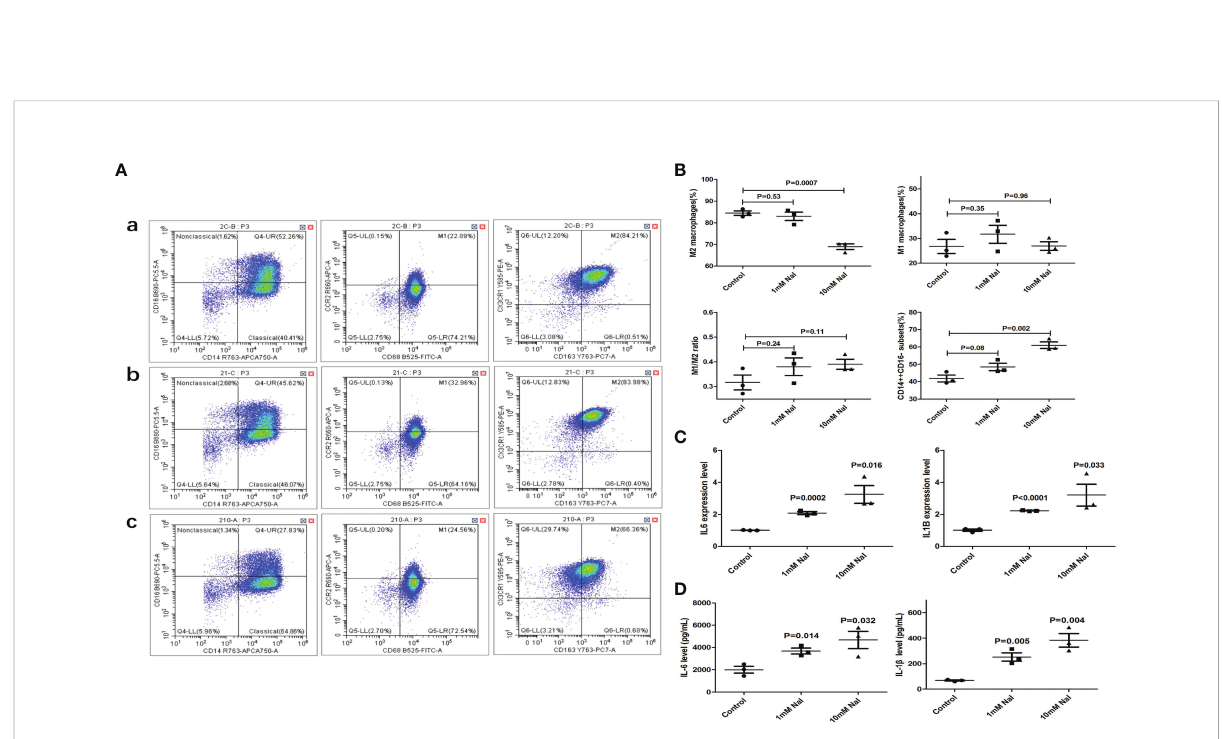
FIGURE 3 High iodine stimulation of human PBMCs. (A) Flow cytometry of macrophage proportions. a: 0 mM of NaI control group; b:1mM of NaI intervention group; c: 10mM of NaI intervention group; (B) Statistics of macrophage proportions (10mM NaI could signi fi cantly reduce the proportion of M2 macrophages and increase the proportion of pro-in fl ammatory monocytes); (C) qRT-PCR results; (D) CBA results of